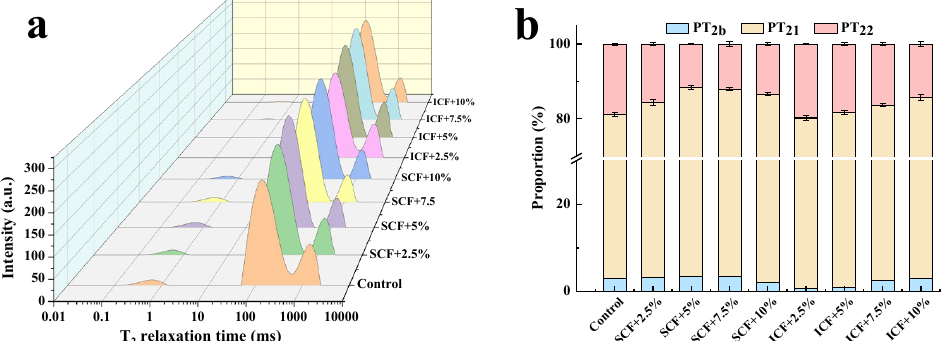
Figure 3. Effects of SCF and ICF on the distribution of the T 2 relaxation times ( a ) and peak areas ( b ) of MP gels.